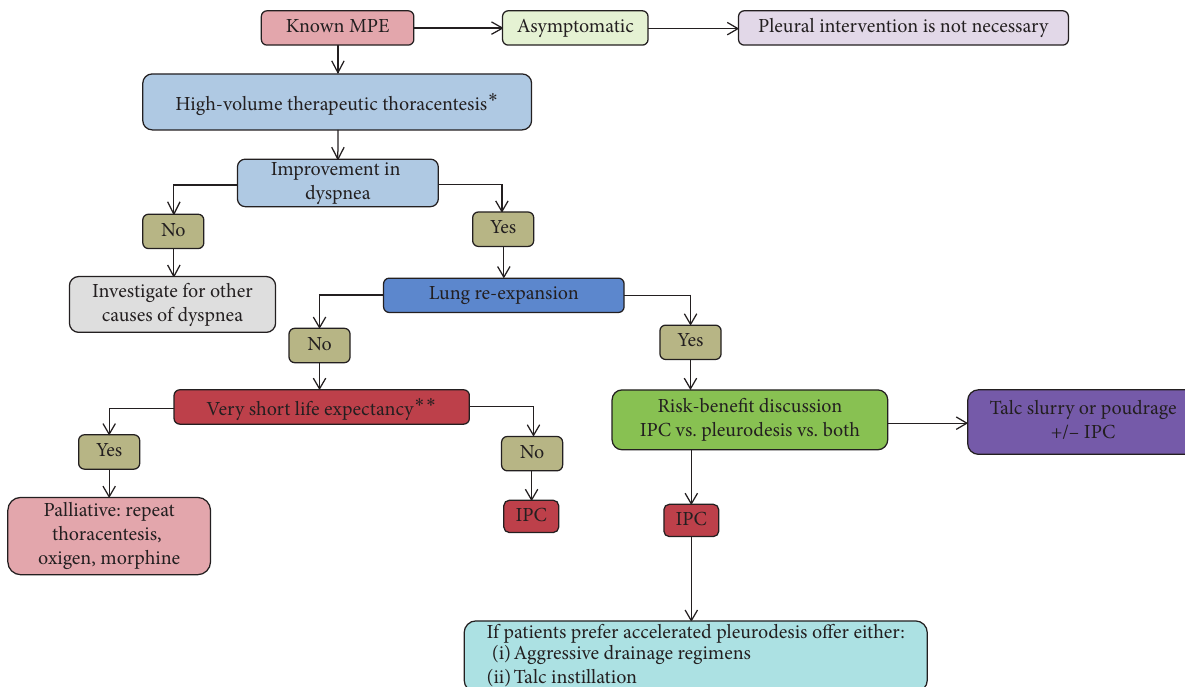
Figure 3: Management of patients with known malignant pleural effusion (adapted from Feller-Kopman et al.) [1]. IPC, indwelling pleural catheter; MPE, malignant pleural effusion. ∗ With the aim of evaluating lung expansion and improvement of dyspnea. ∗∗ In an approximate and individualized